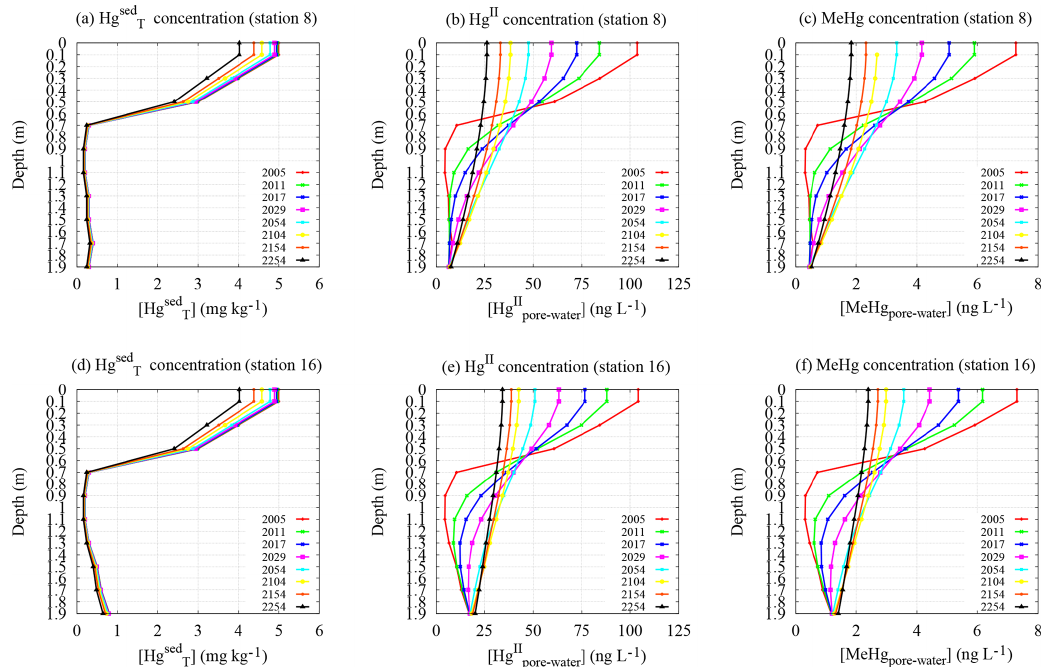
] in sediments (a, d) as well as [ Hg II ] and [MeHg] in pore waters (b, c, e, f) at stations T